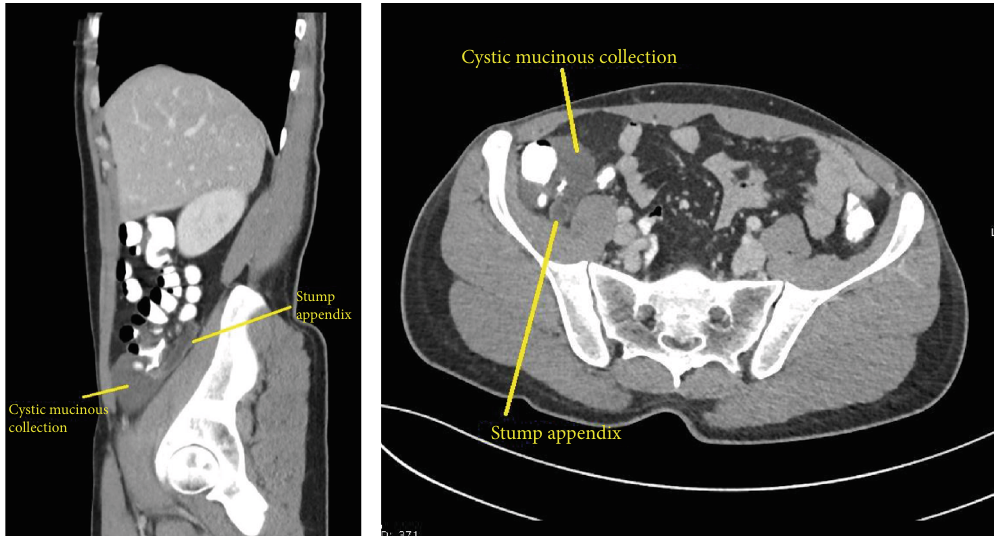
Figure 1: These sagittal and axial cuts from CT scan after appendectomy shows fl uid- fi lled mildly distended appendicular stump with no abnormally thickened wall. An adjacent well-de fi ned fl uid collection is seen caudally, showing a density of 20 Houns fi eld units. (Figure 1). The patient underwent laparoscopic exploration with excision of the subserosal appendicular stump of about 5 cm and cyst extending from the tip and distal part of the appendix to the pelvis, easily separable from the pelvis, con- taining gelatinous yellowish material (Figures 2 – 4). The ter- minal ileum and right-sided colon were normal, and no